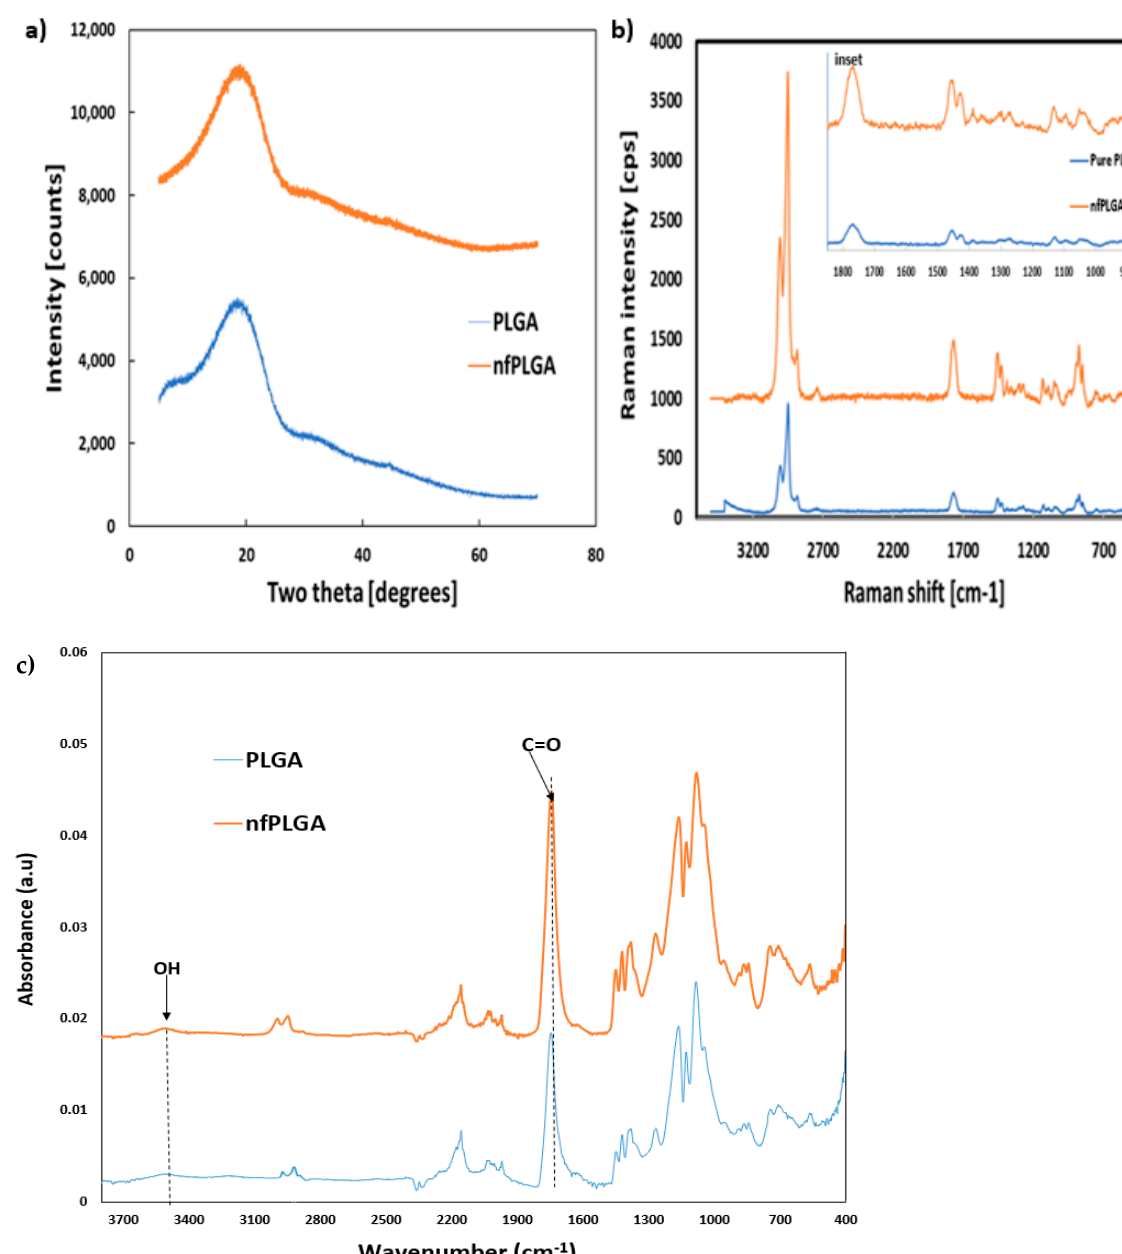
Figure 2. ( a ) XRD, ( b ) RAMAN, and ( c ) FTIR analysis for pure PLGA and nf PLGA particles.